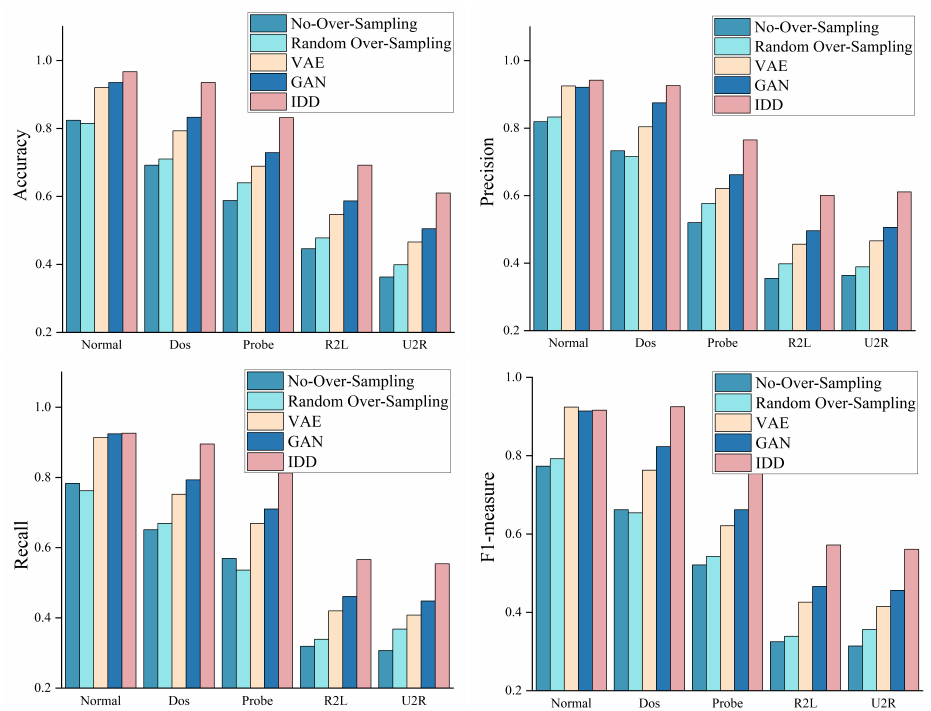
Figure 4. Classification performance of BiLSTM on data generated by different generative models (NLS-KDD dataset).